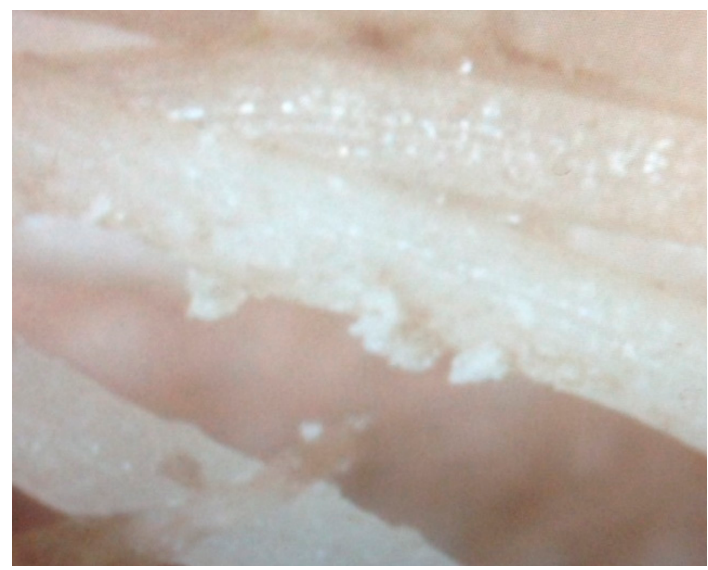
Figure 5. White precipitate observed on the roots of the H7 treatment from a dissecting scope inspection; root diameters are